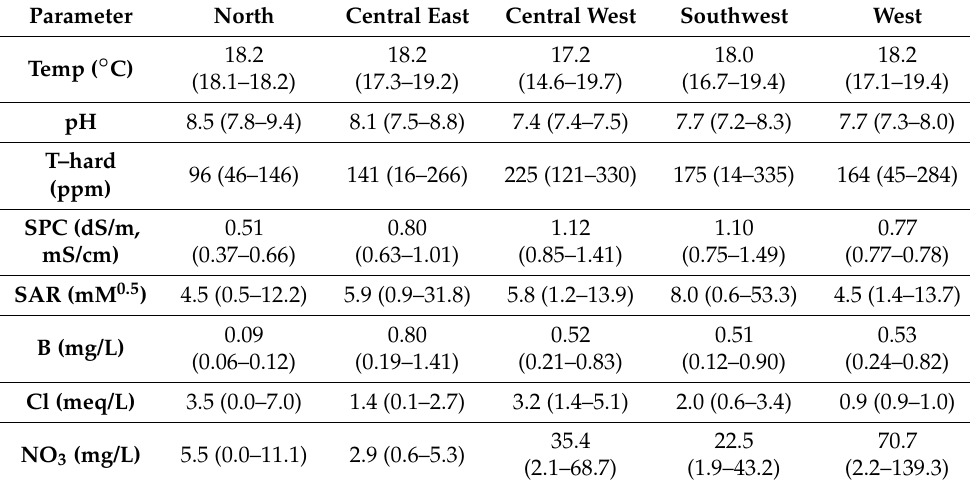
Table 8. Blended water quality results for Dockum and Ogallala wells in the vicinity of each other, within the same spatial grouping. The first value indicates the predicted parameter results for the 50/50 blend of the two aquifers. Numbers in parentheses are the minimum to maximum range allowed considering all binary blend possibilities.